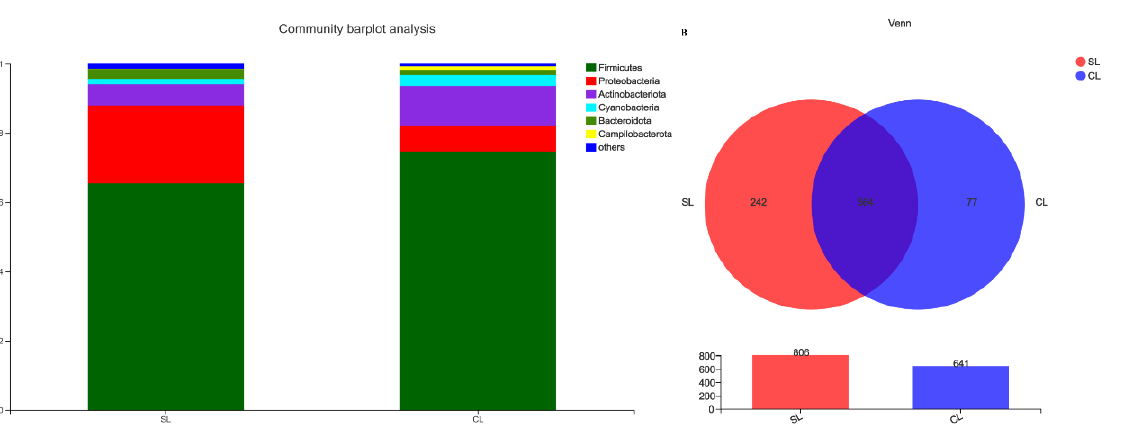
Figure 2. ( A ) represents the composition of intestinal microbiota of Anser fabalis at the phylum level; ( B ) shows the Venn diagram of intestinal microbiota in Anser fabalis at the genus level. Lactobacillus was the main genus in both SL and CL A. fabalis , with a relative abundance of 39.54% and 38.69%, respectively. In SL A. fabalis , the relative abundance of Pseudomonas was 7.34%, that of Enterococcus was 6.99%, and that of Bacillus was 6.09%. In CL A. fabalis , the relative abundance of Subdoligranulum was 5.02%, that of Exiguobacterium was 4.68%, and that of Terrisporobacter was 4.40% (Figure 3A). At the species level, the species L. aviaries was most abundant in both SL and CL A. fabalis , with a relative abundance of more than 34%. The annotated species of intestinal microbiota of SL A. fabalis were followed by Enterococcus faecium (relative abundance 6.99%), Mitochondria (relative abundance 4.67%), Bacillus (relative abundance 5.92%), Lactobacillus (relative abundance 2.70%), and Pseudomonas (relative abundance 4.56%). The annotated species of intestinal microbiota of CL A. fabalis were followed by Mitochondria (relative abundance 2.54%), Lac- tobacillus (relative abundance 3.81%), and Geosporobacteria (relative abundance 4.40%) (Figure 3B). Figure 3. ( A ) shows the composition of intestinal microbiota of Anser fabalis at the genus level; ( B ) represents the composition of intestinal microbiota of Anser fabalis at the species level. The composition and average relative abundances of the top 15 genera in the intesti- nal microbiota of SL and CL A. fabalis were compared and analyzed. It was found that Subdoligranulum ( p < 0.05), Exiguobacterium ( p < 0.01), and Terrisporobacter ( p < 0.05) had higher abundance in the intestinal microbiota of CL Anser fabalis , while Streptococcus ( p < 0.05) and Rothia ( p < 0.05) were more abundant in the intestinal microbiota of SL A. fabalis (Figure 4).